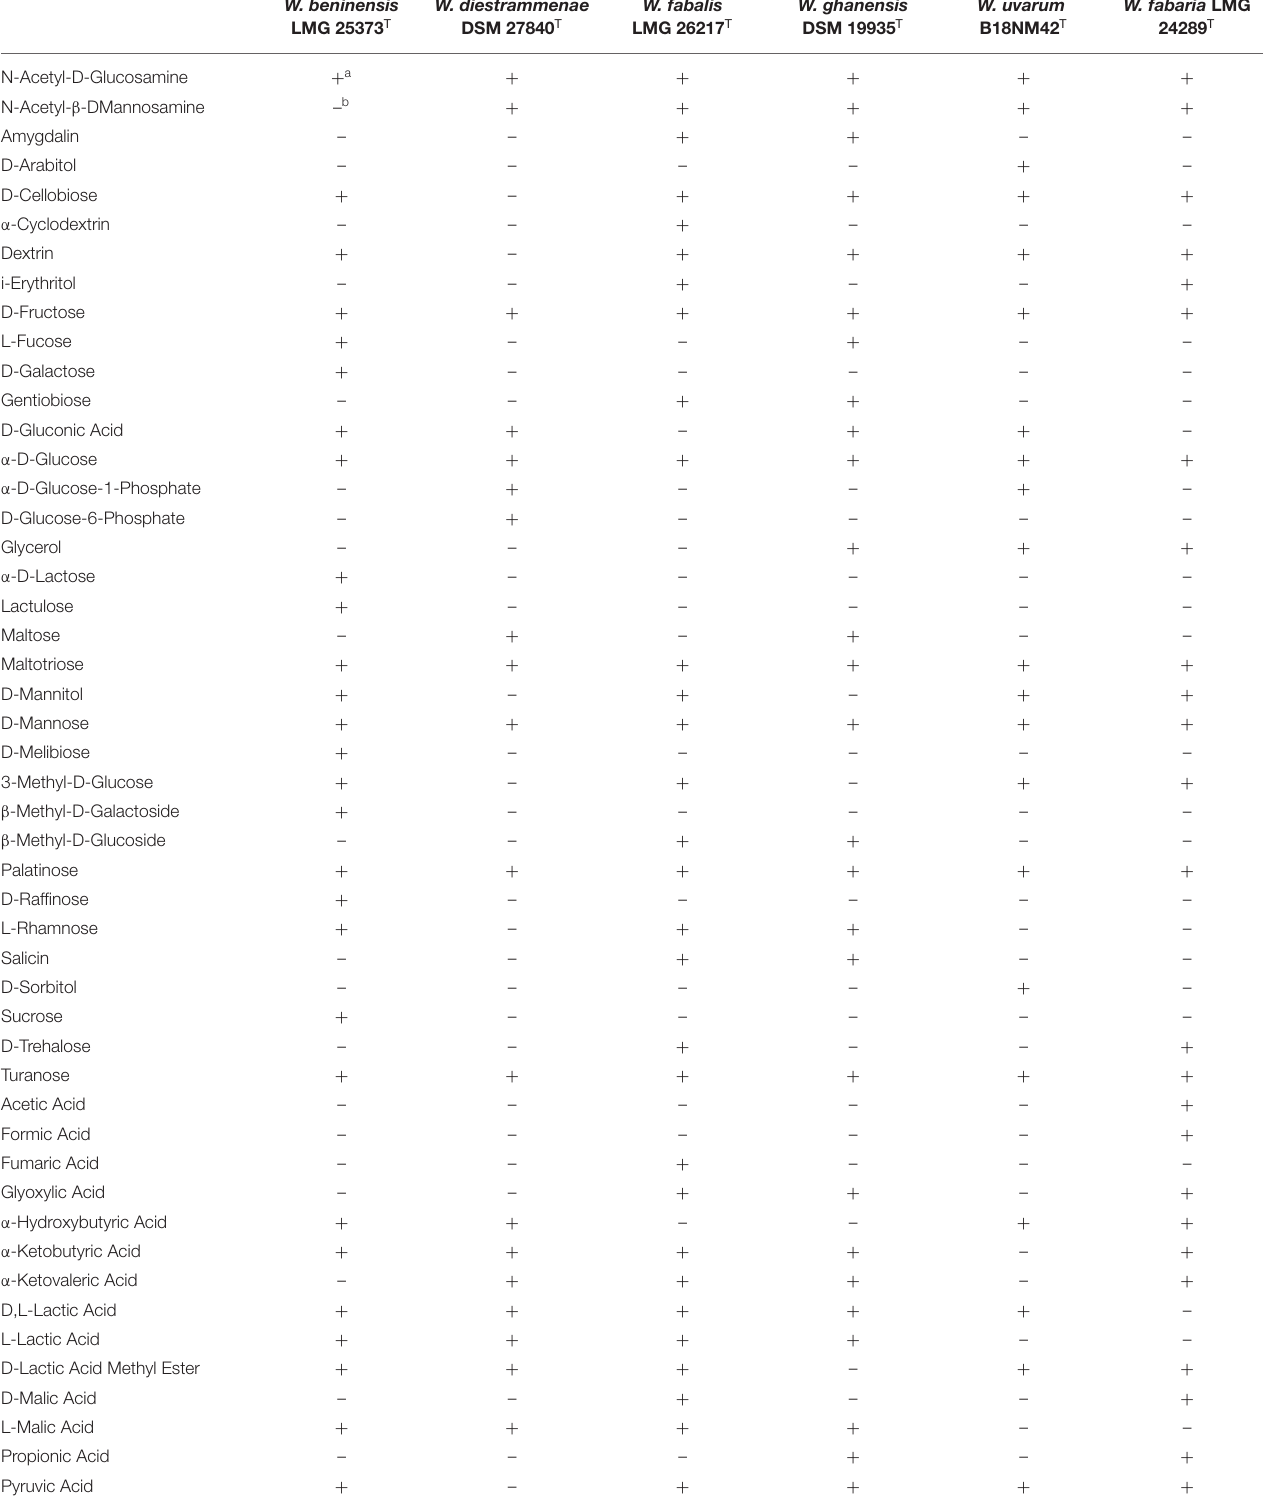
TABLE 3 | Consumption of carbon sources by Weissella strains evaluated after anaerobic incubation of Biolog AN MicroPlate (Biolog,